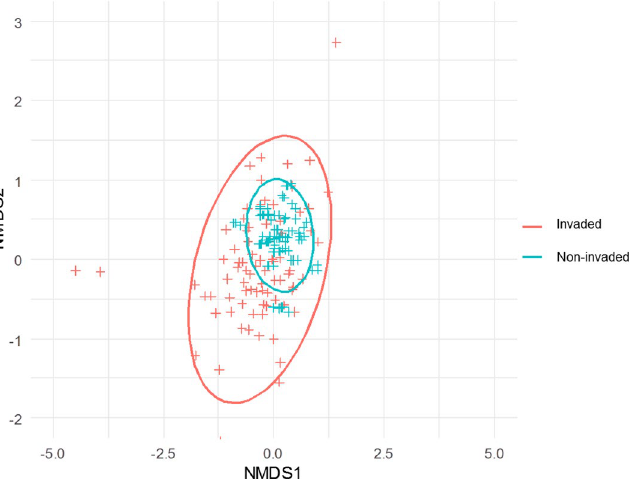
Figure 2. Non-metric multidimensional scaling analysis (NMDS) showing the differences in the native species composition between invaded plots and non-invaded ones (stress = 0.09 for the two axes). Red crosses represent invaded plots, blue crosses non-invaded ones. The colored ellipses are centered on the centroid of both groups and their size is proportional to the standard error of the coordinates of the corresponding points.